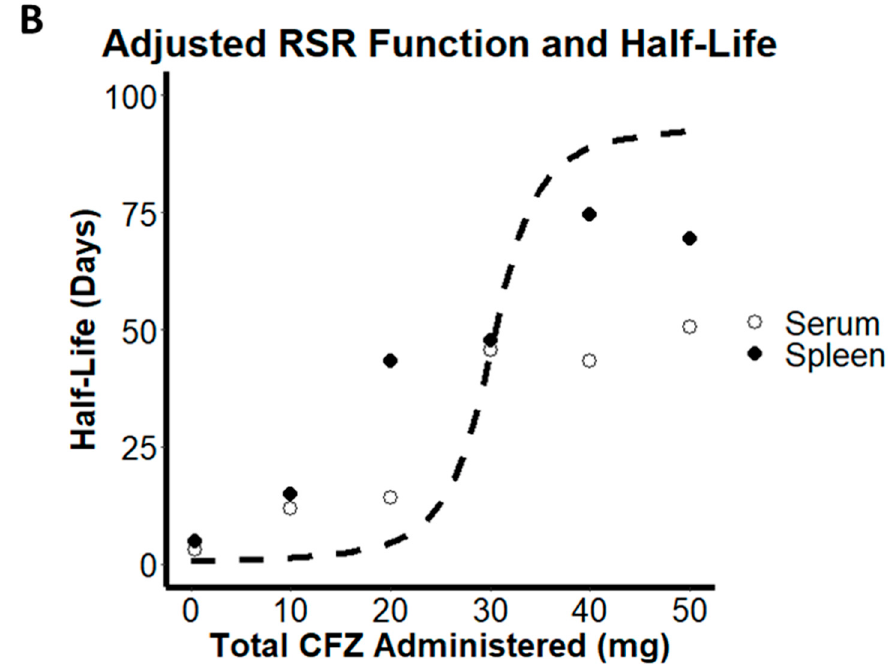
Figure 3. Drug half-life in the organism is related to the cumulative dose administered: ( A ) Load dependent relationship between total CFZ administered and the resulting half-life follows a linear regression in the serum (dotted) and spleen (dashed). ( B ) Calculated serum (open circle) and spleen (closed circle) half-lives plotted against the predicted half-life from the body with the RSR function optimized within 2-fold range of upper and lower observed half-life. Table 2. Eight dosing regimens were evaluated from literature. * Evaluated at 3 weeks instead of 2 weeks. † Infected with M. tuberculosis (studies 3–8). References: Studies 1, 3–8 [11], Study 2 [12]. BALB/c mice were used in each of the observed dosing